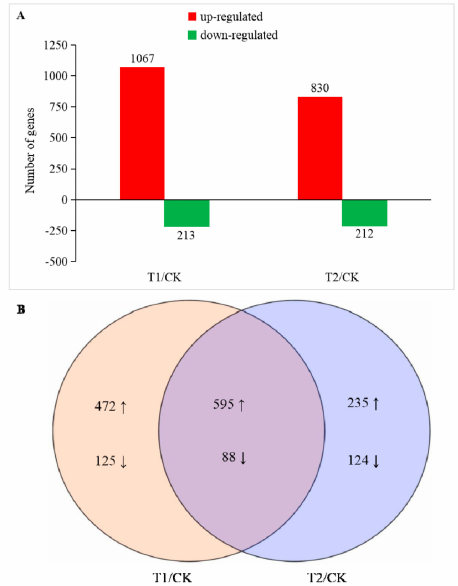
Figure 3. Number of di ff erentially expressed genes (DEGs) in T1 and T2 compared with CK. ( A ) Number of up and downregulated DEGs in T1 and T2 compared with CK, respectively. ( B ) Venn-diagram of significantly di ff erent DEGs identified in T1 / CK and T2 / CK. The significance of the DEGs was measured using the criteria of | Log 2 FoldChange | ≥ 1 and false discovery rate (FDR) ≤